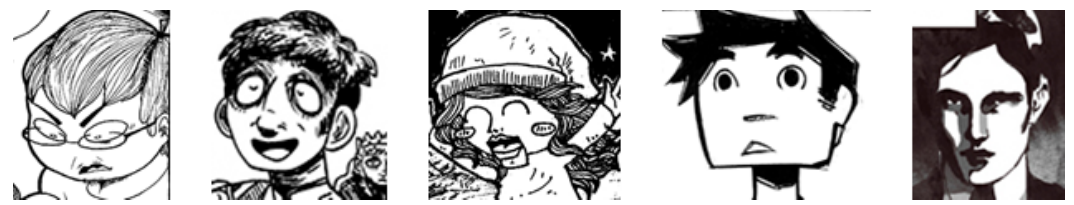
Figure 3. Different examples of comics character faces. Some parts of the face such as the nose, eyes, or mouth can be deformed to emphasize the emotion of the character. The original images are extracted from the BAM! dataset [11].